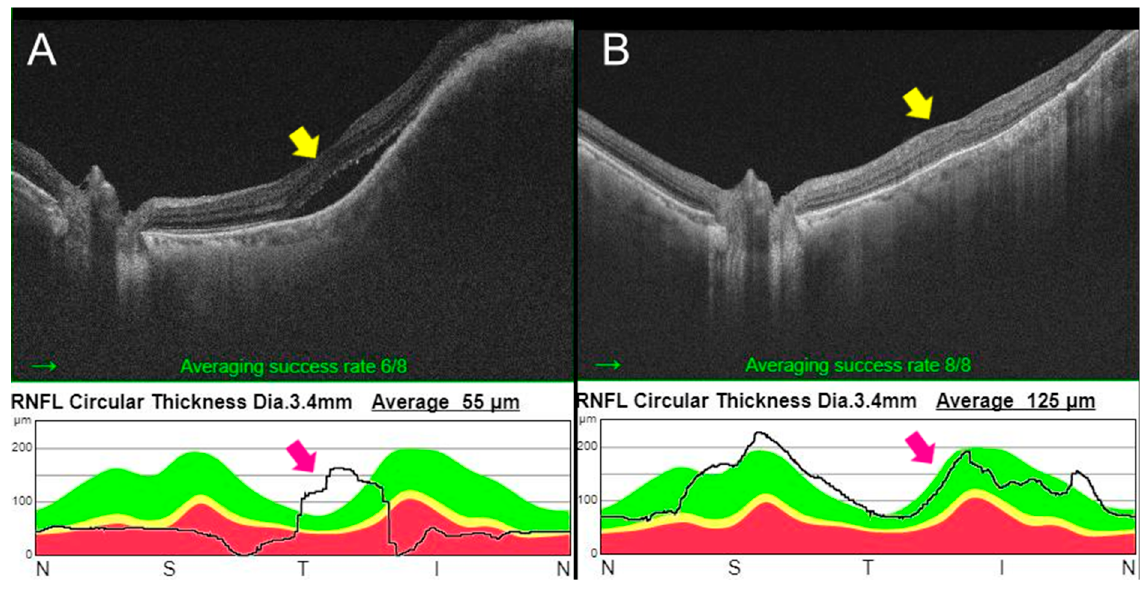
Figure 3. Optical coherence tomography (OCT) of left eye in Case 2 before and at one month after selpercatinib treatment; Image ( A ), before treatment; Image ( B ), after treatment; thickening of choroidal layers with irregular anterior surface is a typical feature of choroidal metastasis at OCT. It is well observed in ( A ) (yellow arrow) but not observed in ( B ). The thickness of each layer was out of normal range before treatment. It was improved after treatment (purple arrow, the black line).